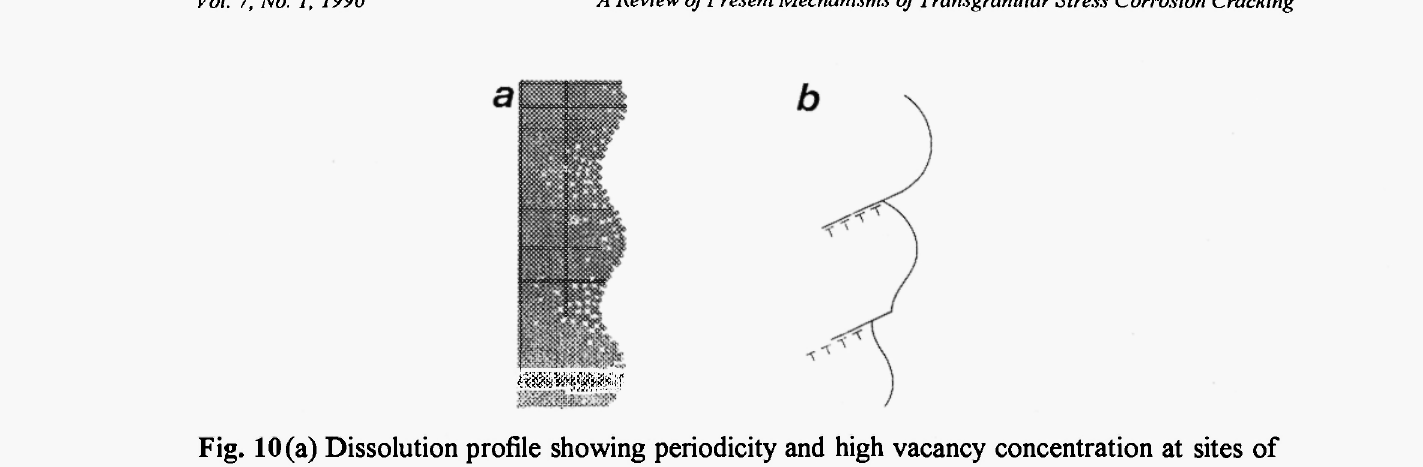
Fig. 10(a) Dissolution profile showing periodicity and high vacancy concentration at sites of maximum corrosion penetration, (b) Evolution of the environment-induced deformation localization pattern according to the periodicity of the dissolution